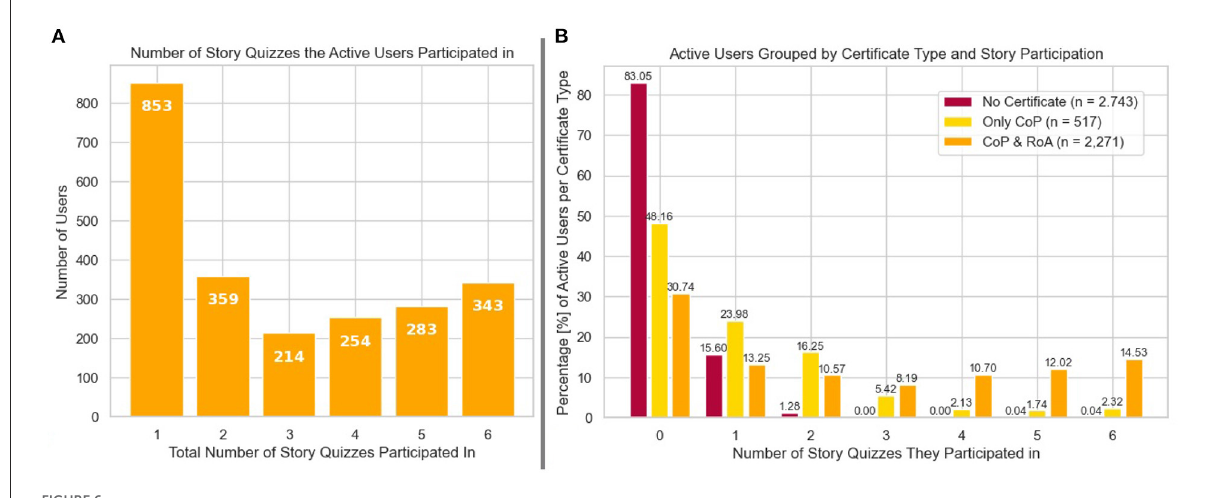
FIGURE6 Left (A) : Number of story quiz answers (Hagedorn et al., 2022) for active users. 3.225 active users did not participate in any of the story quizzes. Left (B) : Story quiz participation for active users, grouped by their achieved certificate type and the number of quizzes participated in.